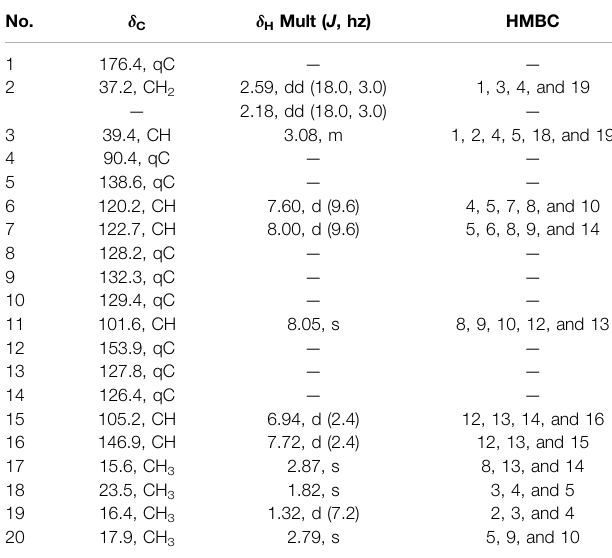
TABLE 1 | 1 H (600 MHz) and 13 C NMR (150 MHz) spectral data of compound 1 in CDCl 3 ( δ in ppm, J in